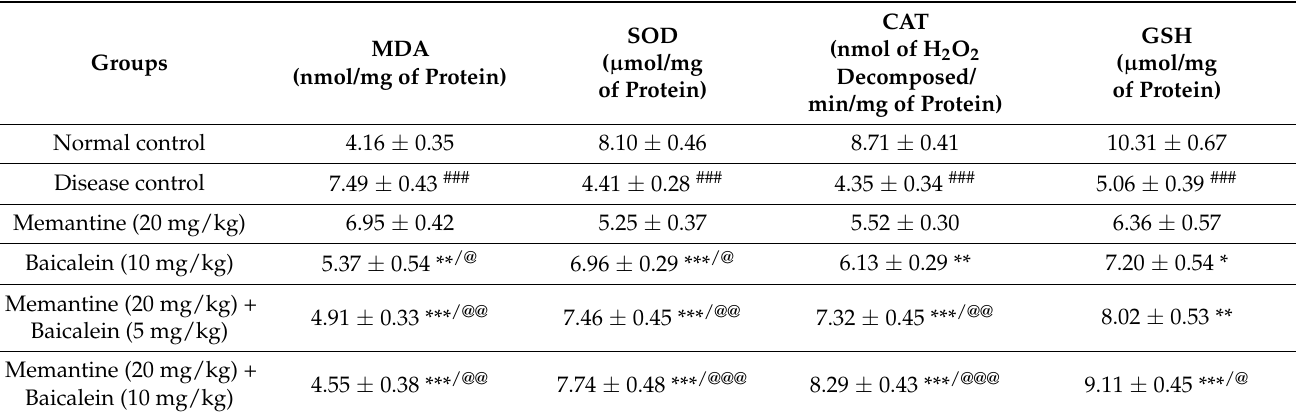
Table 2. Effect of A β (1–42) , baicalein and baicalein with memantine on oxidative stress parameters in the rat brain cortex.